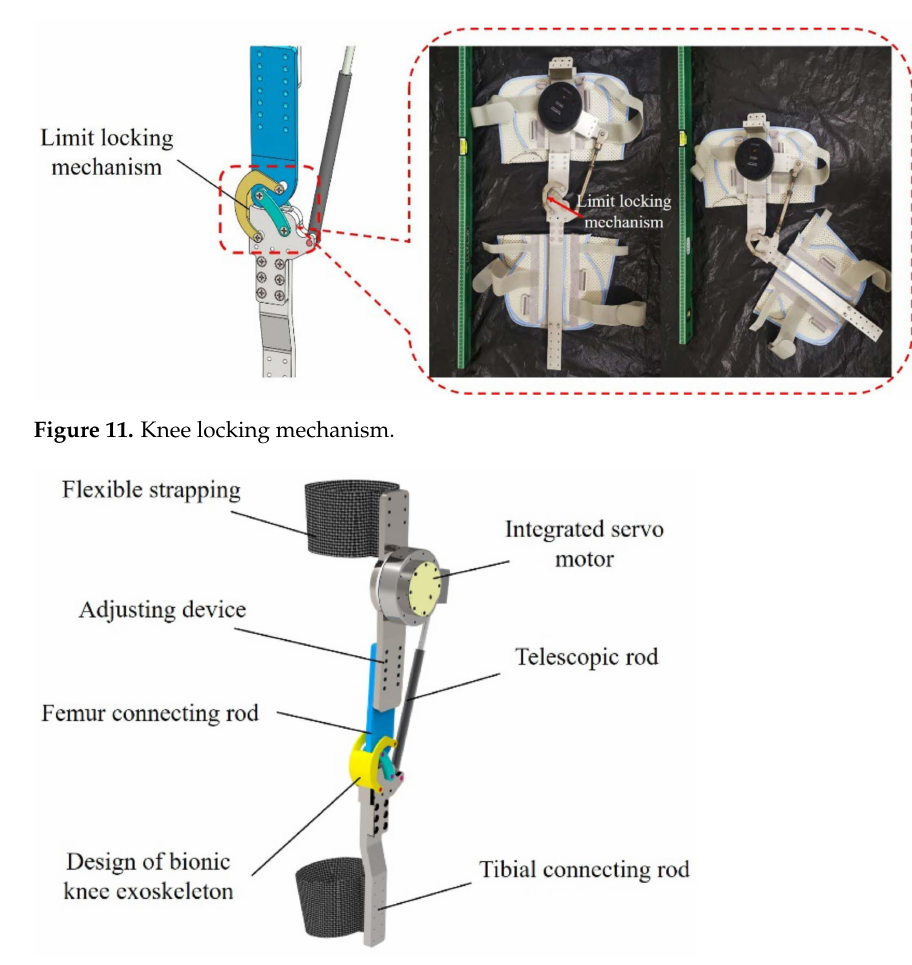
Figure 12. Biomimetic artificial knee exoskeleton